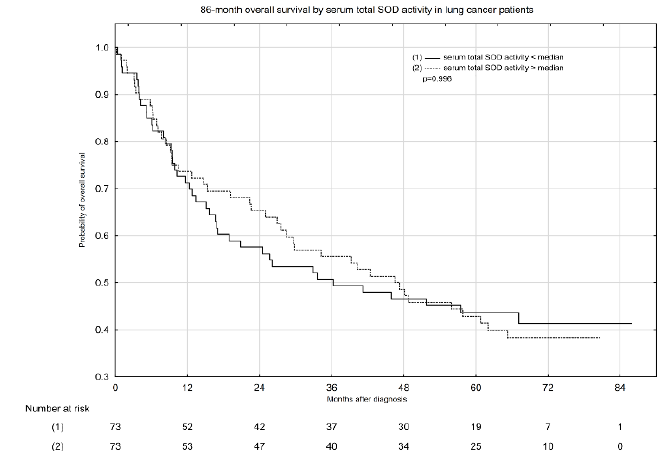
Figure 1. Eighty-six-month overall survival by serum total SOD activity in lung cancer patients.